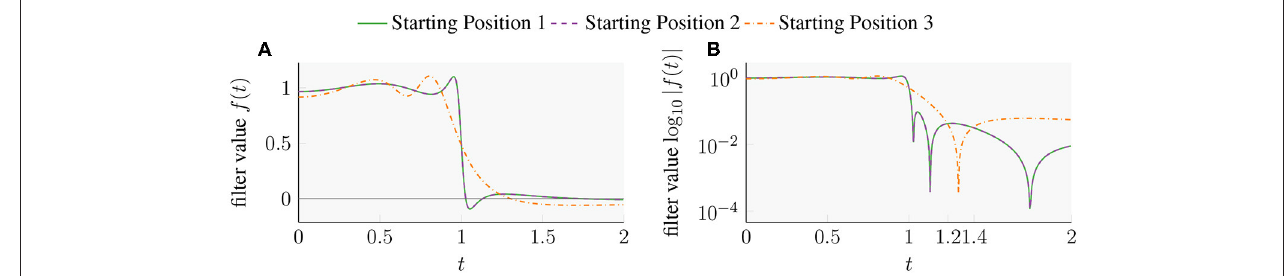
FIGURE 5 | (A) Three SLiSe filters obtained from gradient descent with different starting positions. (B) Semi-log plot with absolute value of the filter functions. The poles and residuals of the functions are listed in Table 1